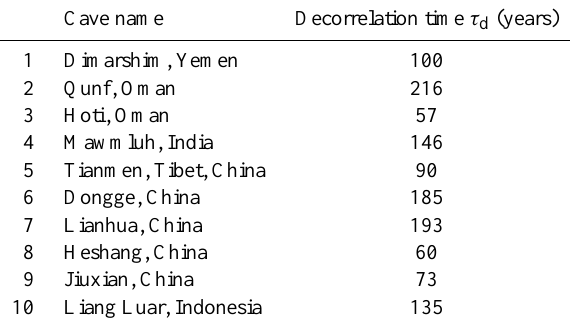
Table 2. Decorrelation time τ d of speleothem oxygen isotope records determined as the first zero-crossing of the auto-correlation function (ACF). The ACF was computed from the detrended time series using a Gaussian kernel estimator applied to the original ir- regularly sampled records (kernel bandwidth h = (cid:104) (cid:49)T (cid:105) / 4 as sug- gested by Rehfeld et al., 2011). A sliding-window detrending was applied with a 1000-year bandwidth for all